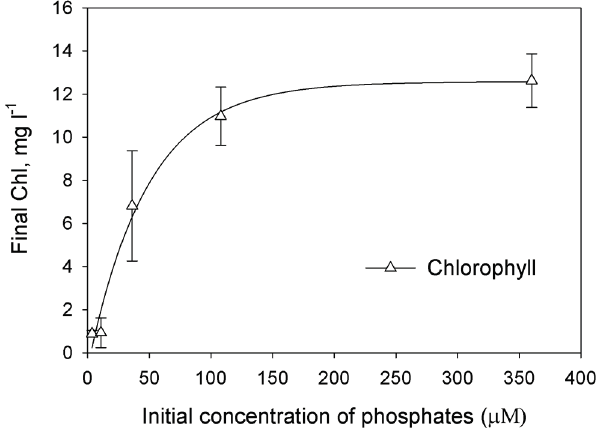
Figure 1. The effect of the initial phosphates concentration on the accumulation of the biomass (measured as the final Chl concentration). Each point represents the average of three independent repetitions. The curve was drawn as nonlinear regression, modified Hyperbola